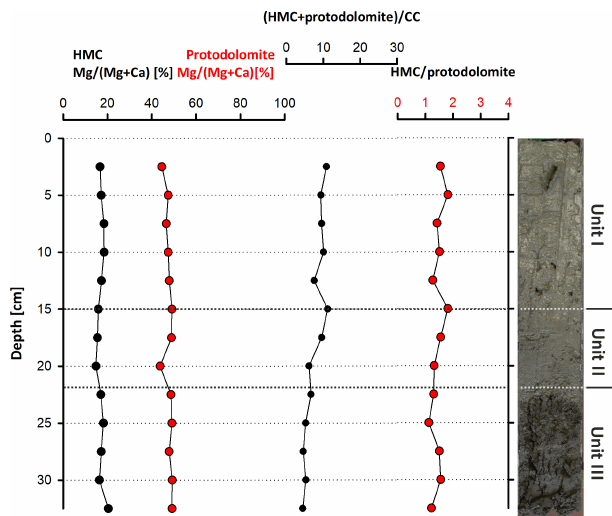
Figure 8. Stoichiometric compositions of authigenic carbonate phases (HMC and protodolomite), their abundance ratio and their relation to detrital